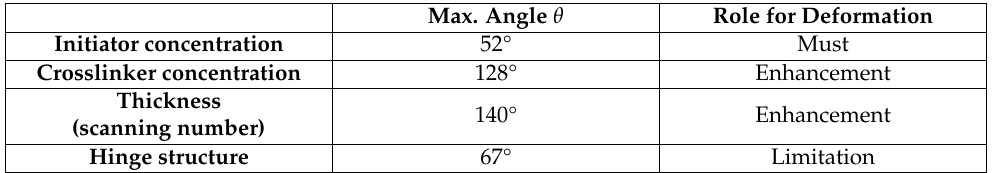
Table 2. Summary of important factors for 4D printing.